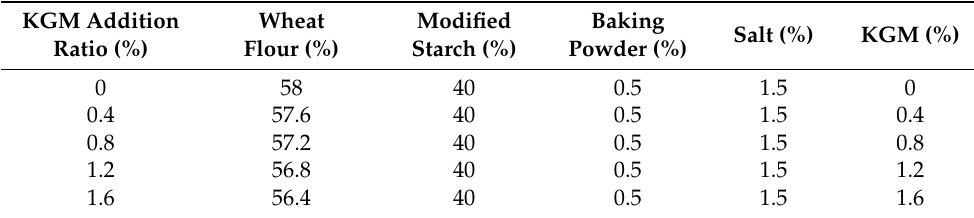
Table 1. Battering